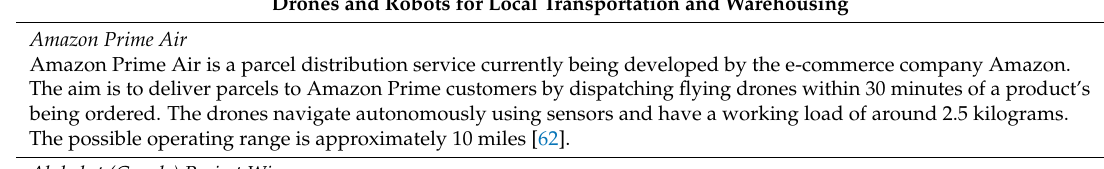
Table 3. Practical examples of the use of drones and robots in local transportation and warehousing. Drones and Robots for Local Transportation and